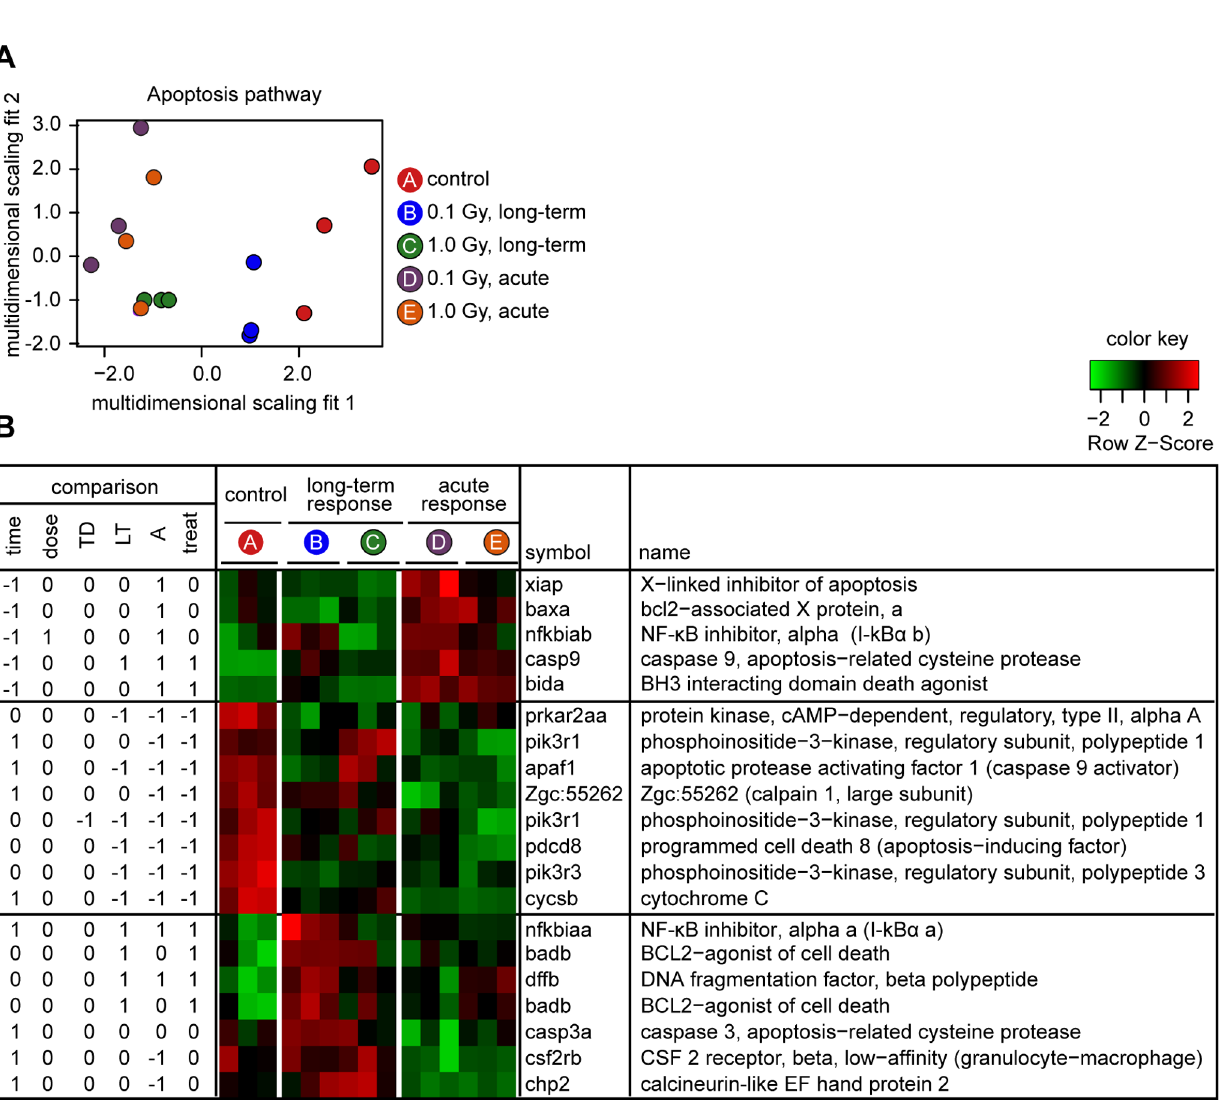
Figure 5. Analysis of apoptosis pathway. A. Multidimensional scaling representation of results for apoptosis pathway, based on 42 probe sets for which data are available, symbols as in Fig. 4. B. Responses for 20 probe sets that showed significant differences in one or more statistical comparisons, depicted and labeled as in Fig. 4. For details of KEGG apoptosis pathway – Danio rerio (zebrafish): (http://www.genome.jp/kegg-bin/ show_pathway?dre04210). Note that the name of badb has been corrected to ‘‘BCL2-agonist of cell death’’ (not ‘‘antagonist’’) in agreement with direct experimental evidence in the zebrafish [34] and the known function of the mammalian ortholog [35]. Table S2 Figure 2C gene list. List of genes that appear in the heat map in Figure 2C. Column labels are the same as for Table Table S1 Figure 2B gene list. List of genes that appear in the S1, except that comparisons are for the acute groups versus the heat map in Figure 2B. Columns contain: Affymetrix probe set ID, control group. gene symbol, gene title, Entrez gene number, Gene Ontology Table S3 Primers for qPCR. List of primers used for experiment in Figure 3. Primers were used to amplify cDNA for indicated genes. Table S4 Figure 4 gene list. List of genes that appear in the heat map in Figure 4. Columns A-G contain: Affymetrix probe set ID, gene symbol, gene title, Entrez gene number, Gene Ontology (Biological Process, Cellular Component, or Molecular Function). The remaining columns contain results for the six statistical comparisons diagrammed in Figure 1: treatment, time, dose, time-